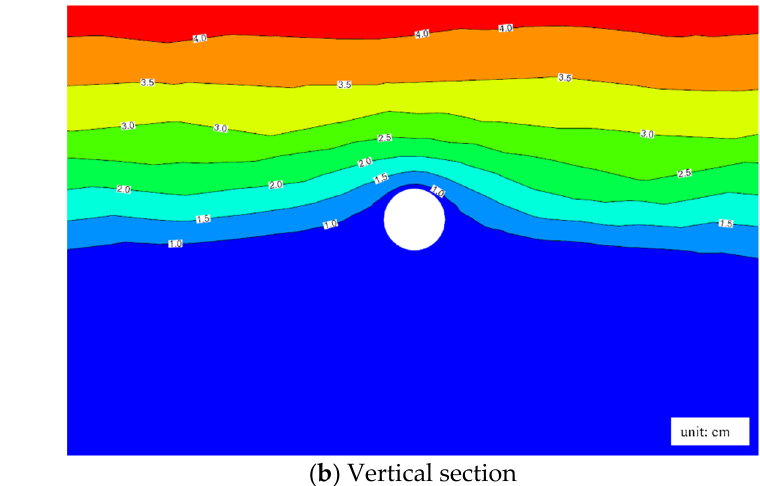
Figure 13. Deformation contour of slope surface and vertical section calculated by the numerical simulation.